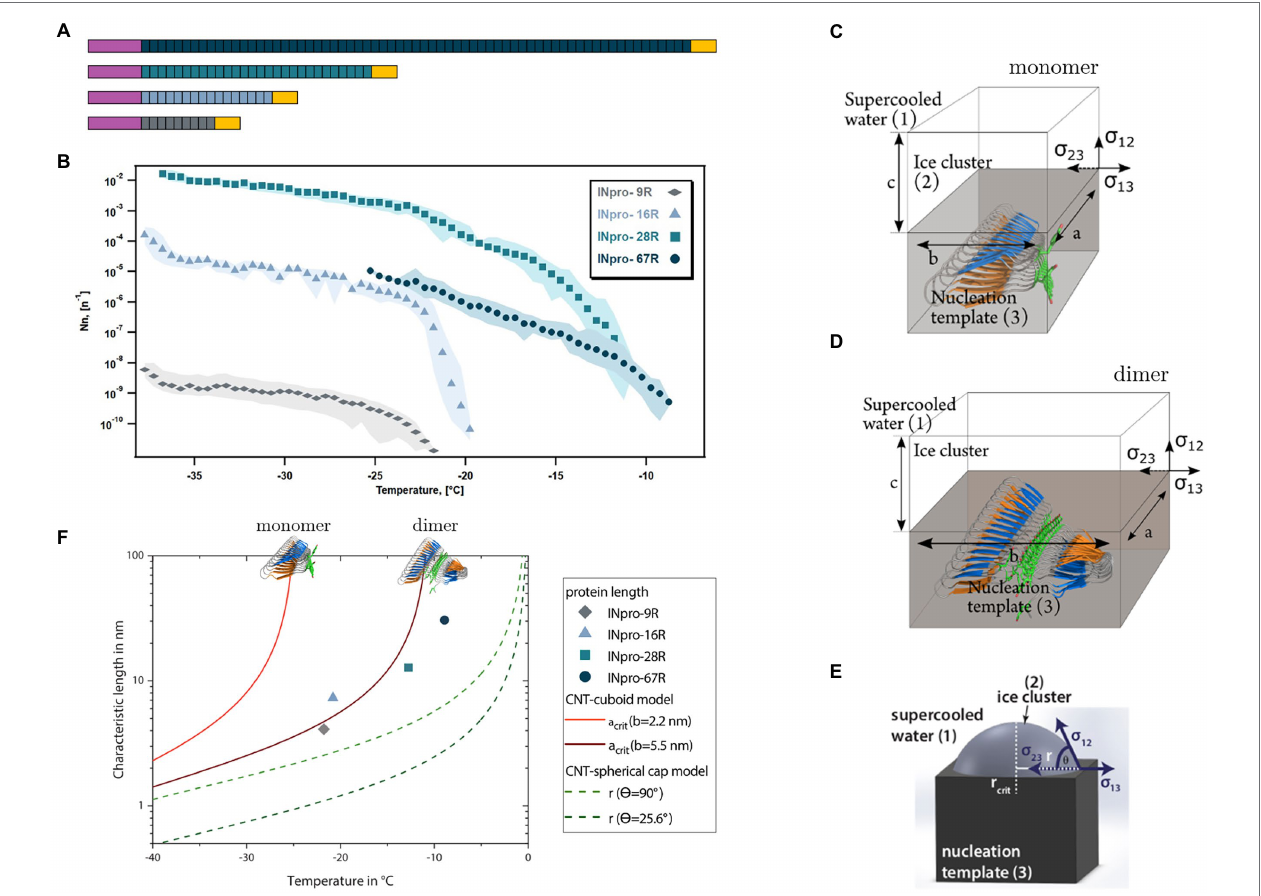
FIGURE 1 | The central repeat region (CRD) is an elongated template for ice nucleation (A) Four INpro constructs were produced to investigate the role of CRD size for the nucleation activity. Purple signifies the N-terminal domain and the yellow signifies the C-terminal domain. The colors of the CRD are used to differentiate the recombinant INpro constructs. (B) Ice nucleation spectra of INpro constructs expressed as ice nucleation site density per molecule ( ) N n as a function of temperature. Each color represents a protein of different length. Averages are shown with maximal and minimal values presented as shaded areas. More detailed figures showing the frozen fractions and the ice nucleation spectra of each protein construct can be found in the SI ( Supplementary Figures S8, S9 ). The quality with which the steepness of the increase was captured depends on the concentration of the purified INpro molecules in each sample. (C,D,E) A sketch of the ice nucleation template (3) and the ice cluster (2) in supercooled water (1) for cuboid geometry proposed based on the ab initio β -helical INpro model (C,D) and spherical cap geometry previously used to model INpro activity (E) . The interfaces are defined via the respective interfacial free energies ij σ of the adjoining phases. The cuboid is determined by three axes (a, b, c), whereas the spherical cap can be described by the critical radius r crit and the contact angle . θ (F) Comparison of the relationship between the characteristic length (a or r in this figure) and the temperature predicted from the cuboid and spherical cap models according to CNT and the experimental measurements of characteristic nucleation temperatures and lengths of INpro dimers determined from the ab initio β -helical model of the